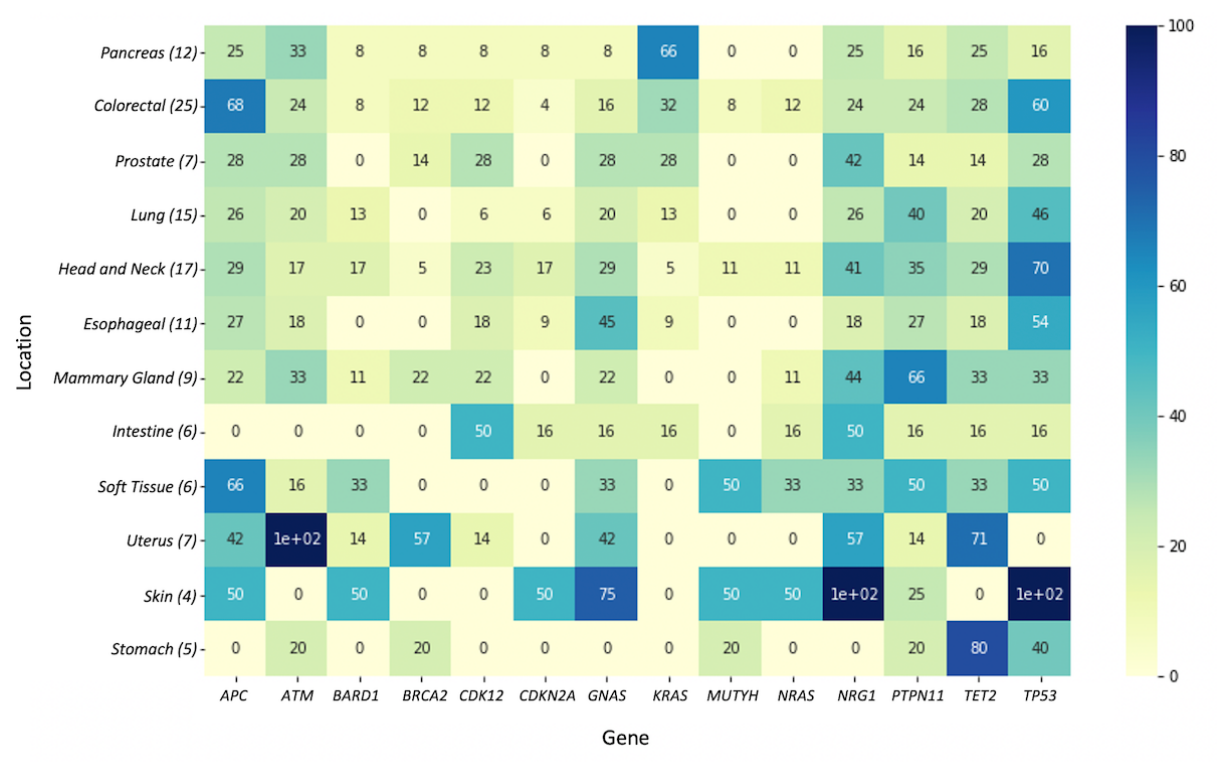
Figure 6. Distribution (%) of the gene mutations by location. Y-axis: location (number of patients); x-axis: gene, eg, 80% for stomach for TET2 means that 4 of 5 patients with stomach cancer had a mutation in TET2